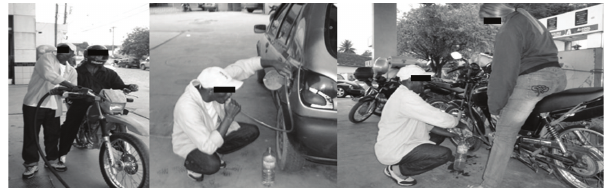
Figure 1: Patient siphoning excess gasoline in filling vehicles due to wrong information provided by the clients.